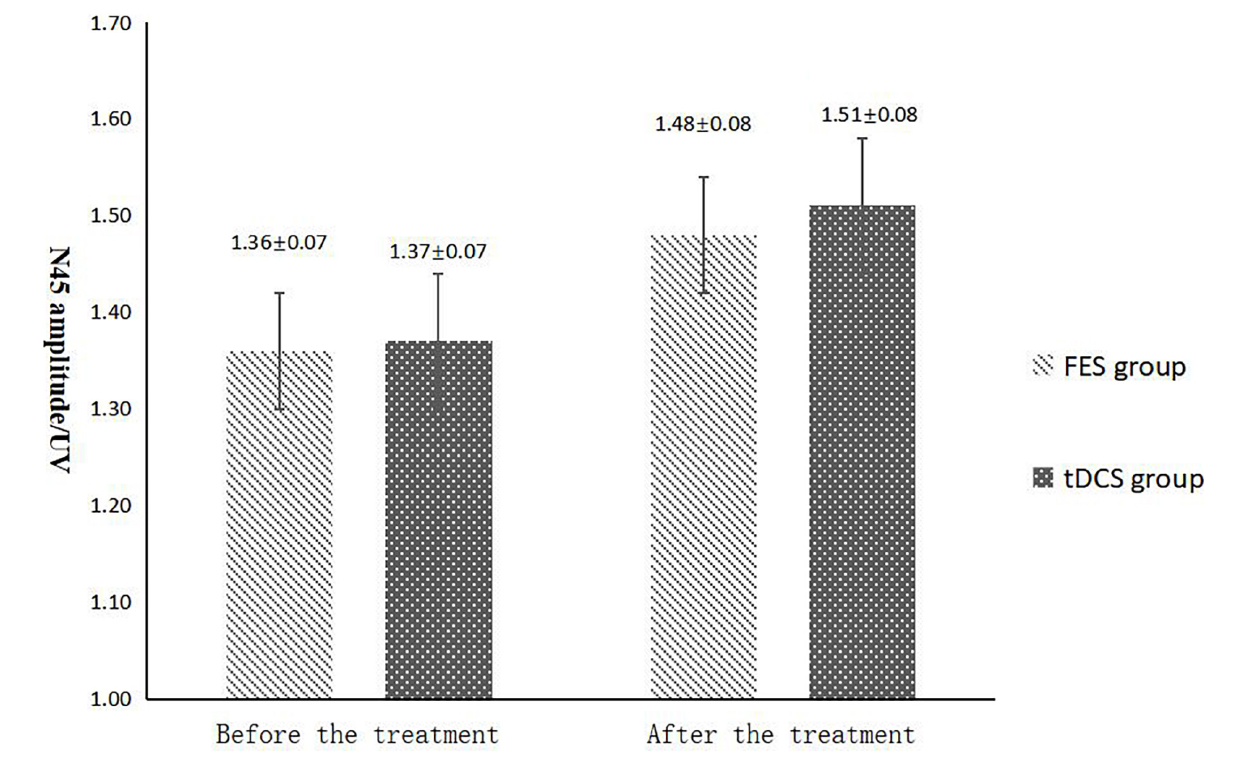
FIGURE 7 | N45 amplitude comparing improvement before and after FES and tDCS treatments in post-convalescent stroke patients. ∗ Indicates that the mean value of the tDCS and FES groups is significantly different at the same time point, p < 0.05. #Indicates that the mean score after treatment is significantly different from that before treatment, p <